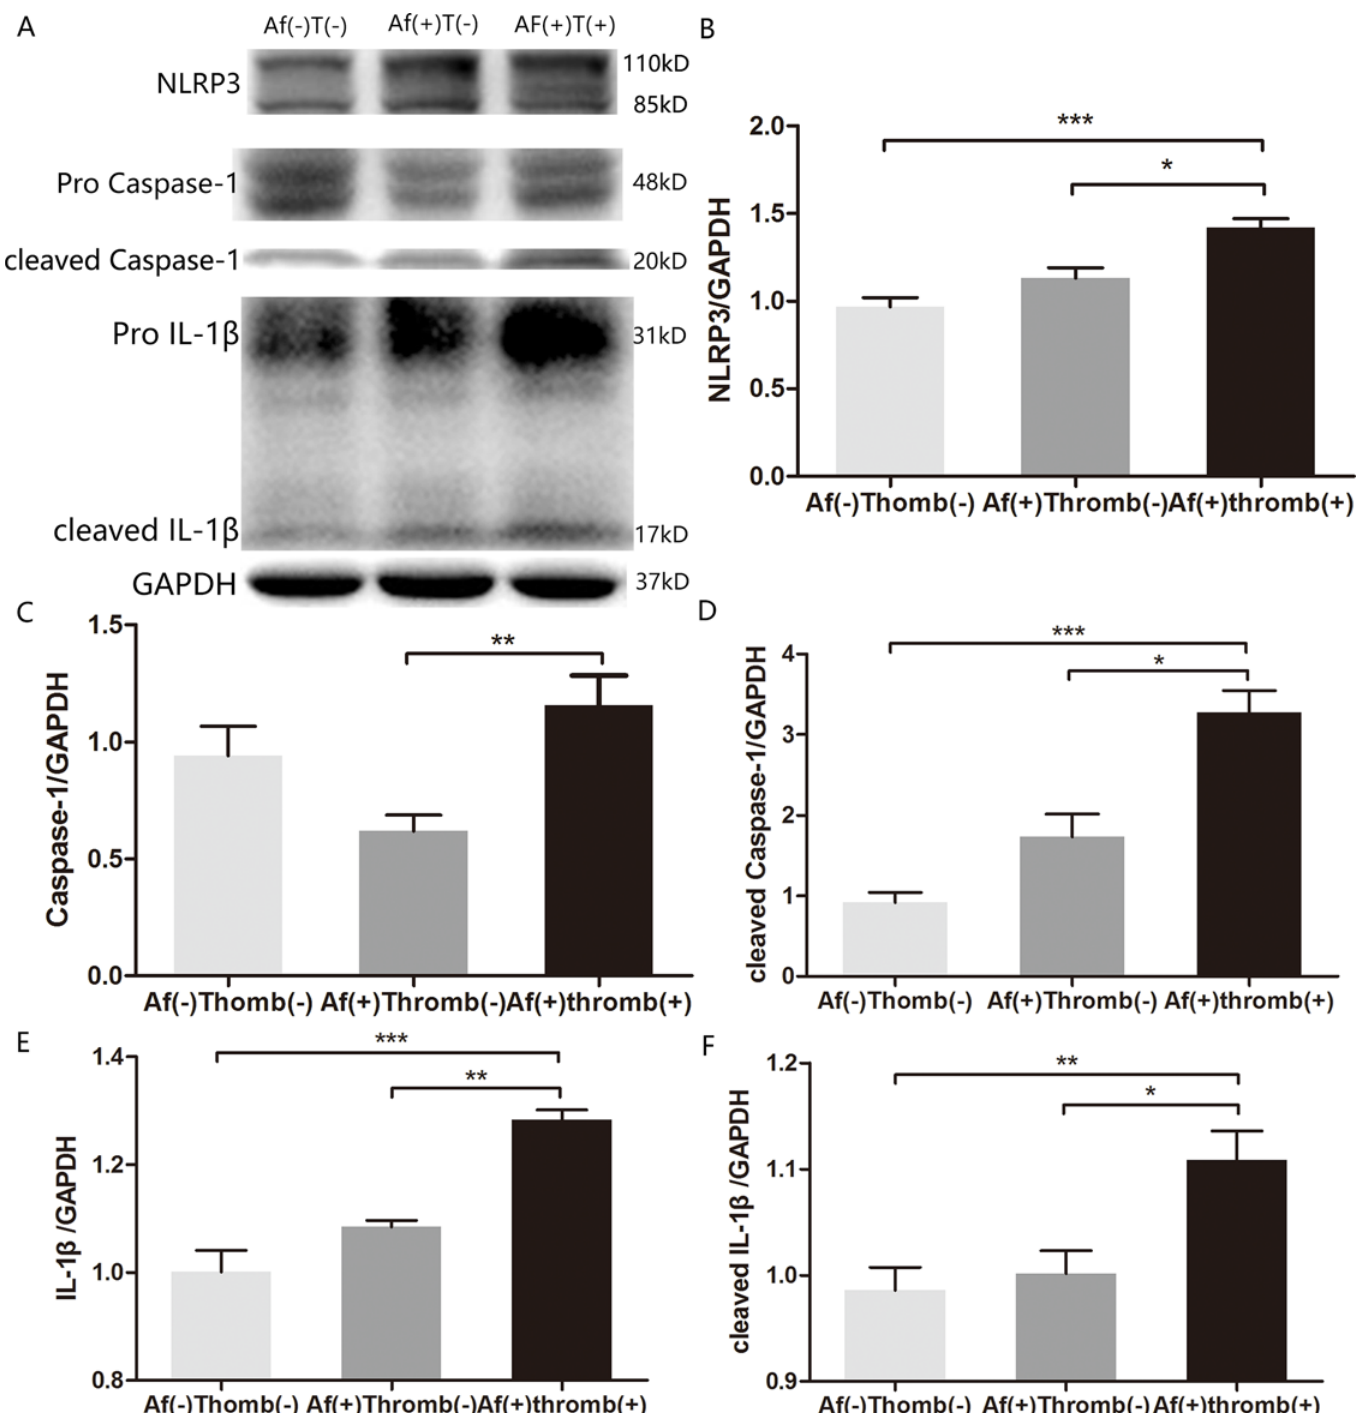
Fig 2. Immunoblot of inflammasome components in lysates of atrium. (A) Representative plot showing expression of NLRP3, pro- and cleaved caspase-1, pro- and cleaved IL-1 β . GAPDH represents the loading control. (B-F) Semiquantitative analysis of inflammasome expression; NLRP3, pro- and cleaved caspase-1, and pro- and cleaved IL-1 β expressions were significantly increased in patients with AF and thrombosis. * denotes P < 0.05, ** denotes P < 0.01, *** denotes P < 0.0001.